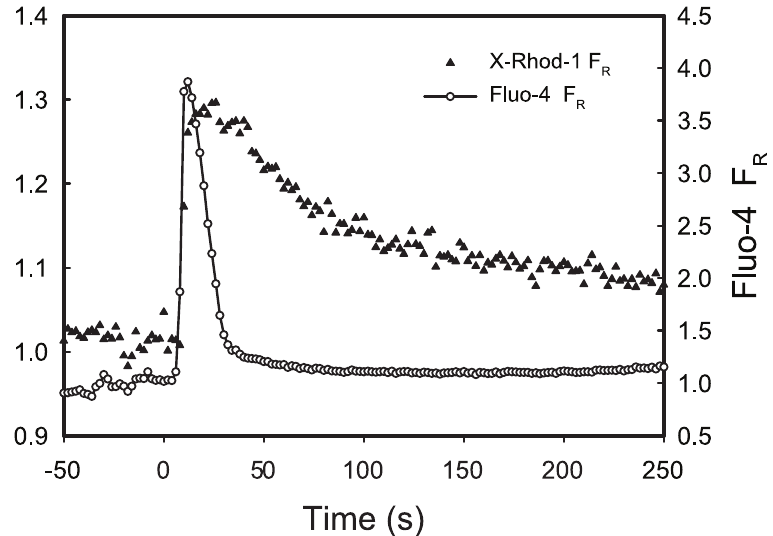
Figure 1. Air bubble contact induces concurrent increases in intracellular and mitochondrial calcium. Representative traces of fluorescence signal (F R ) obtained from HUVEC loaded with mitochondrial calcium dye X-Rhod-1 (left axis, solid triangles) and intracellular calcium dye Fluo-4 (right axis, open circles) responding to air bubble contact at t=0.